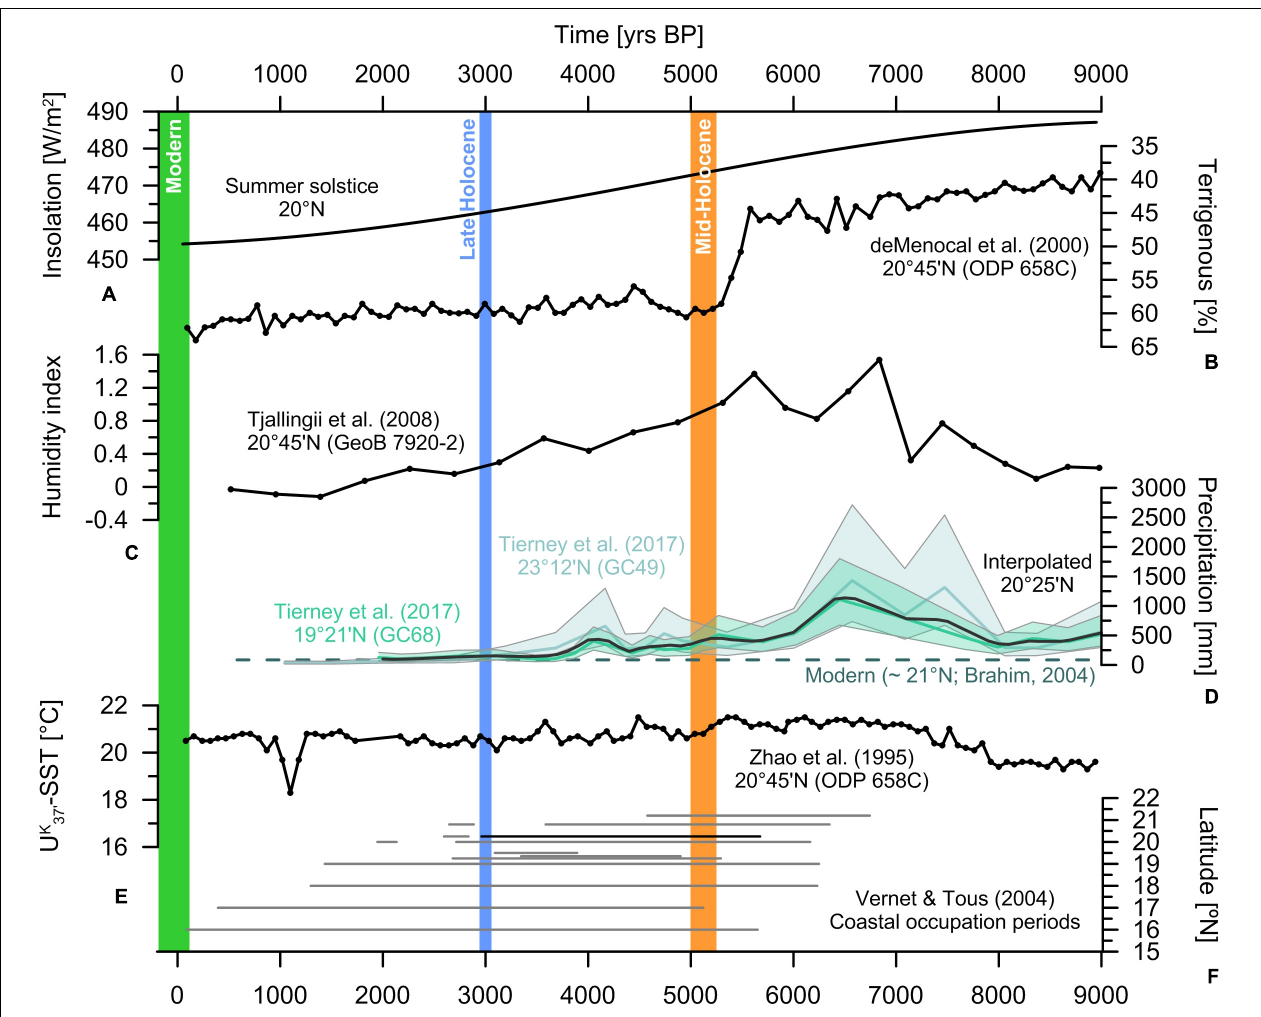
FIGURE 2 | Palaeoclimate records of NW Africa. (A) Summer (solstice) insolation at 20 ◦ N (Laskar et al., 2004). (B) Terrestrial dust export at ODP site 658C (deMenocal et al., 2000). (C) Continental humidity index based on grain-size measurements of GeoB 7920-2 (Tjallingii et al., 2008). (D) δ D-based precipitation reconstruction (Tierney et al., 2017) with a temporal and spatial interpolation at 20 ◦ 25 ◦ N and the modern annual precipitation at ∼ 21 ◦ N (Brahim, 2004). (E) Holocene alkenone water temperature record from ODP site 658C (Zhao et al., 1995). (F) Periods of coastal occupation along the West African coast (Vernet and Tous, 2004). The Ras el Sass area is marked in black. Time periods covered by sample material discussed in this study are shown as green, blue, and orange columns for the modern (2010–2012 AD), late Holocene (ca. 3.0 ka BP), and mid-Holocene (ca. 5.3–5.0 ka BP),